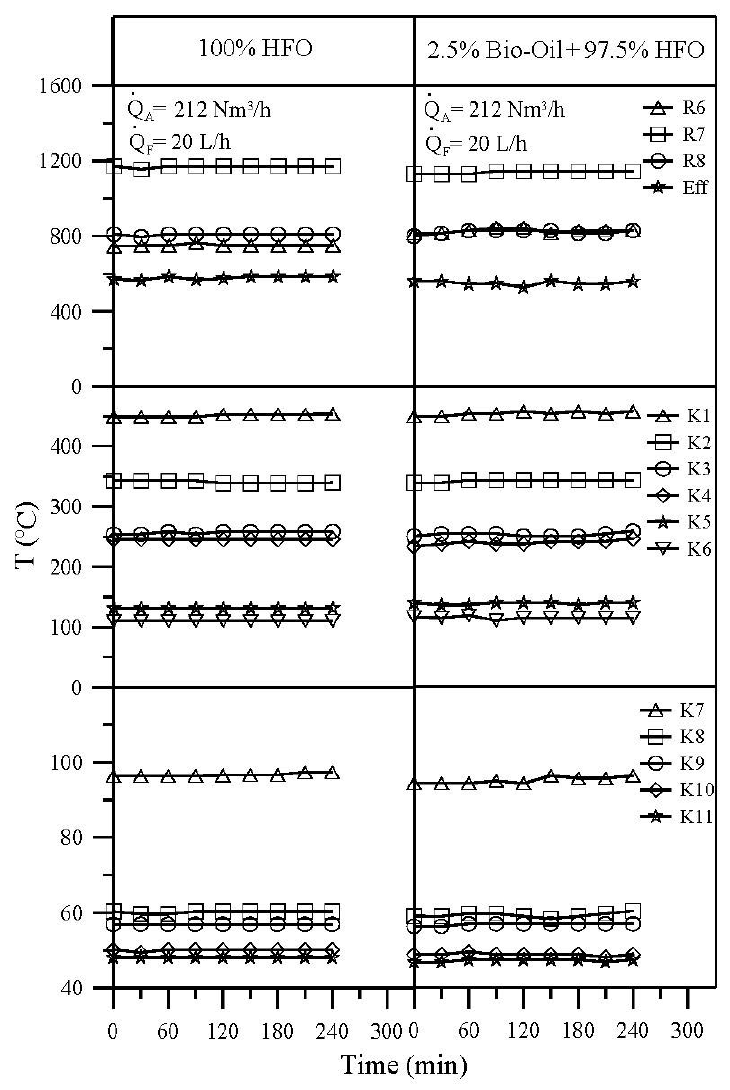
Figure 5. Temperature distributions for burning 100% HFO and the emulsion of 2.5% bio-oil and 97.5% HFO.